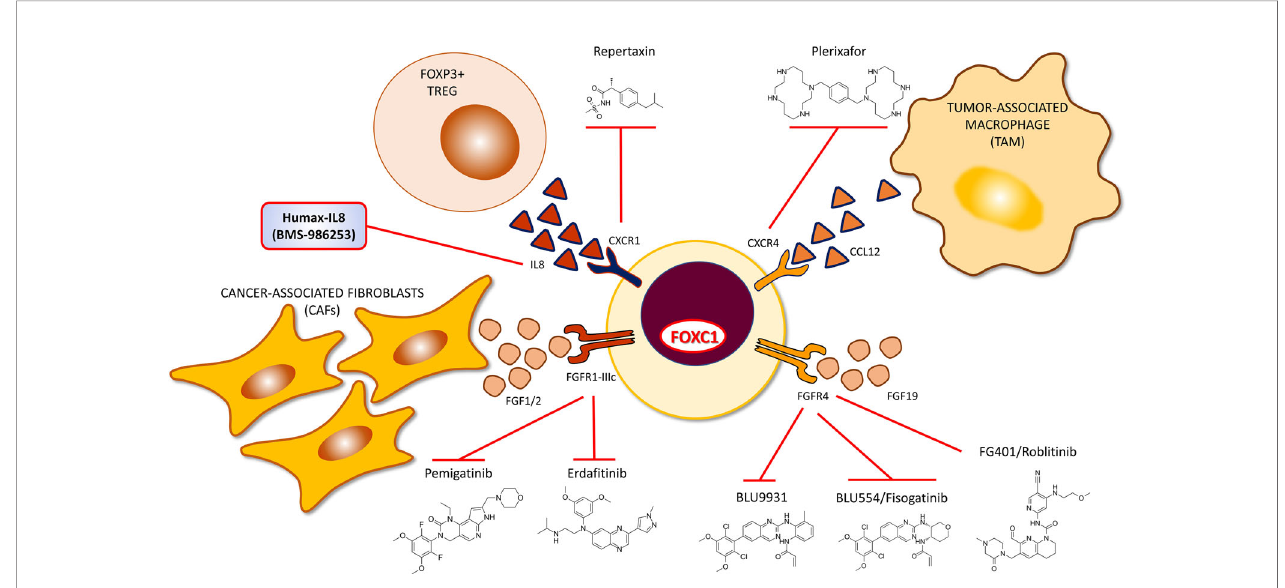
FIGURE 5 | Targeted TME therapy strategies for targeting FOXC1-overexpressing pro-metastatic cancers – III. Drugs that target the IL8, CXCR1, CXCR4, FGFR1 and FGFR4 mediated cell-cell interactions in the tumor